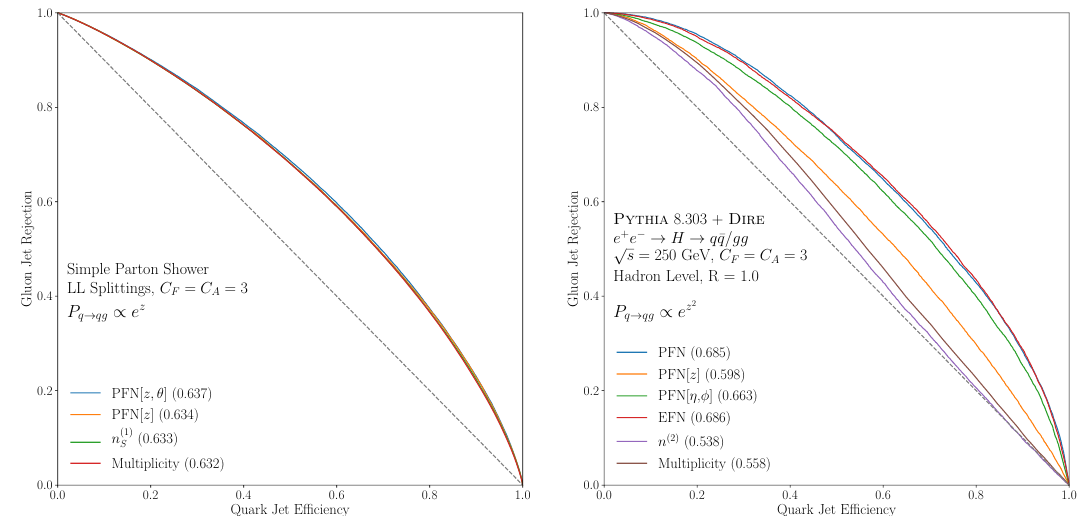
Figure 6 . ROC curves comparing predicted classifier performance to neural networks for two additional event generation paradigms: a dedicated jet generator with explicitly tunable splitting functions (left), and Pythia at hadron-level (right). We observe near-perfect agreement between the DNNs and the likelihood ratio observable in the former case. In the latter case, generator-level hadronization effects severely diminish the performance of the calculated